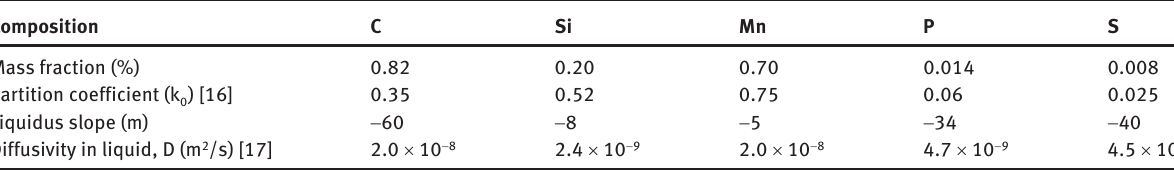
Table 2: The chemical composition of 82B steel and materials properties used in the simulation Composition C